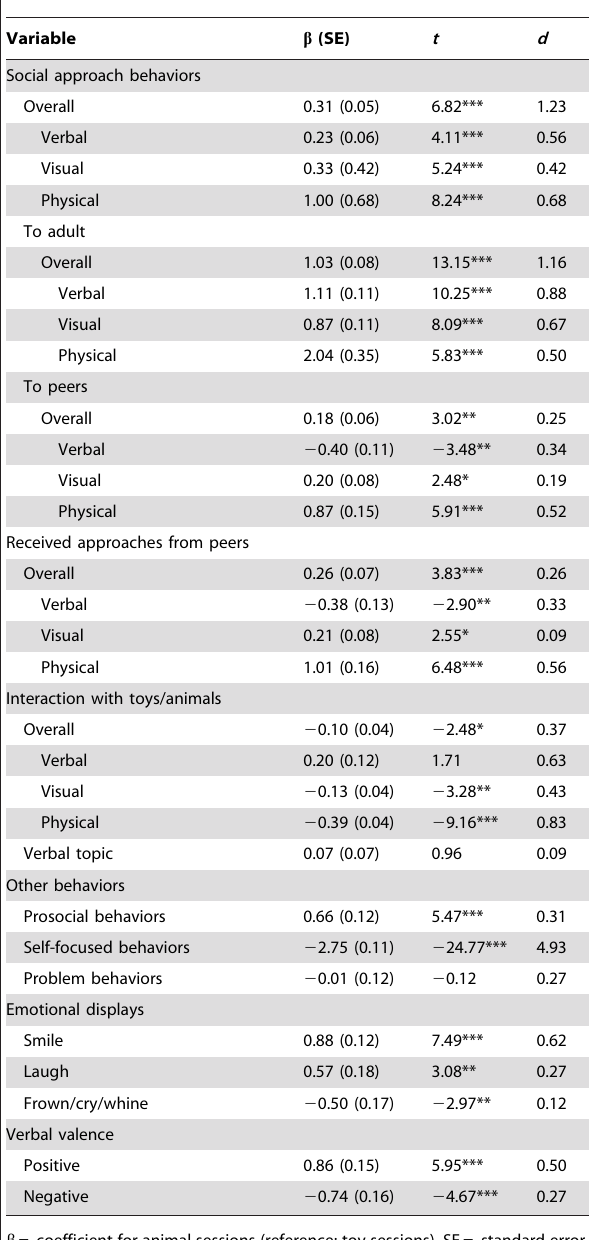
Table 2. Effect of toy versus animal presence on behavioral